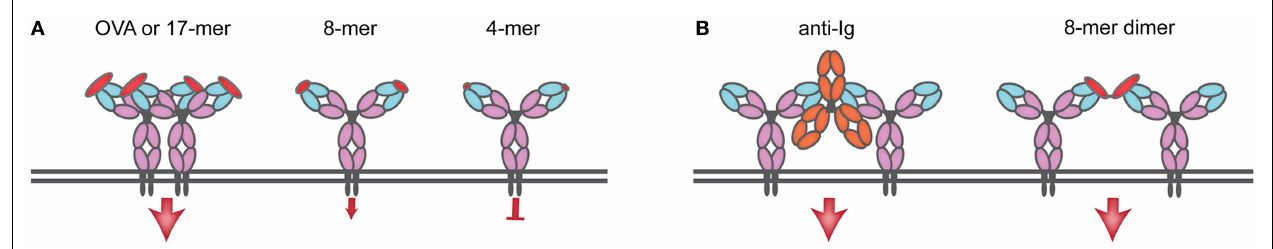
FIGURE 1 | Monomeric antigen can induce BCR cross-linking and activation as long as a signaling threshold is attained . (A) OB1 B cells bear a BCR specific for ovalbumin (OVA), and activation and cross-linking is produced upon interaction with a 17-mer peptide containing the OB1 epitope and an essential FGD sequence. As the size of the peptide including the FGD sequence decreases, so does the ability to induce signal: an 8-mer peptide